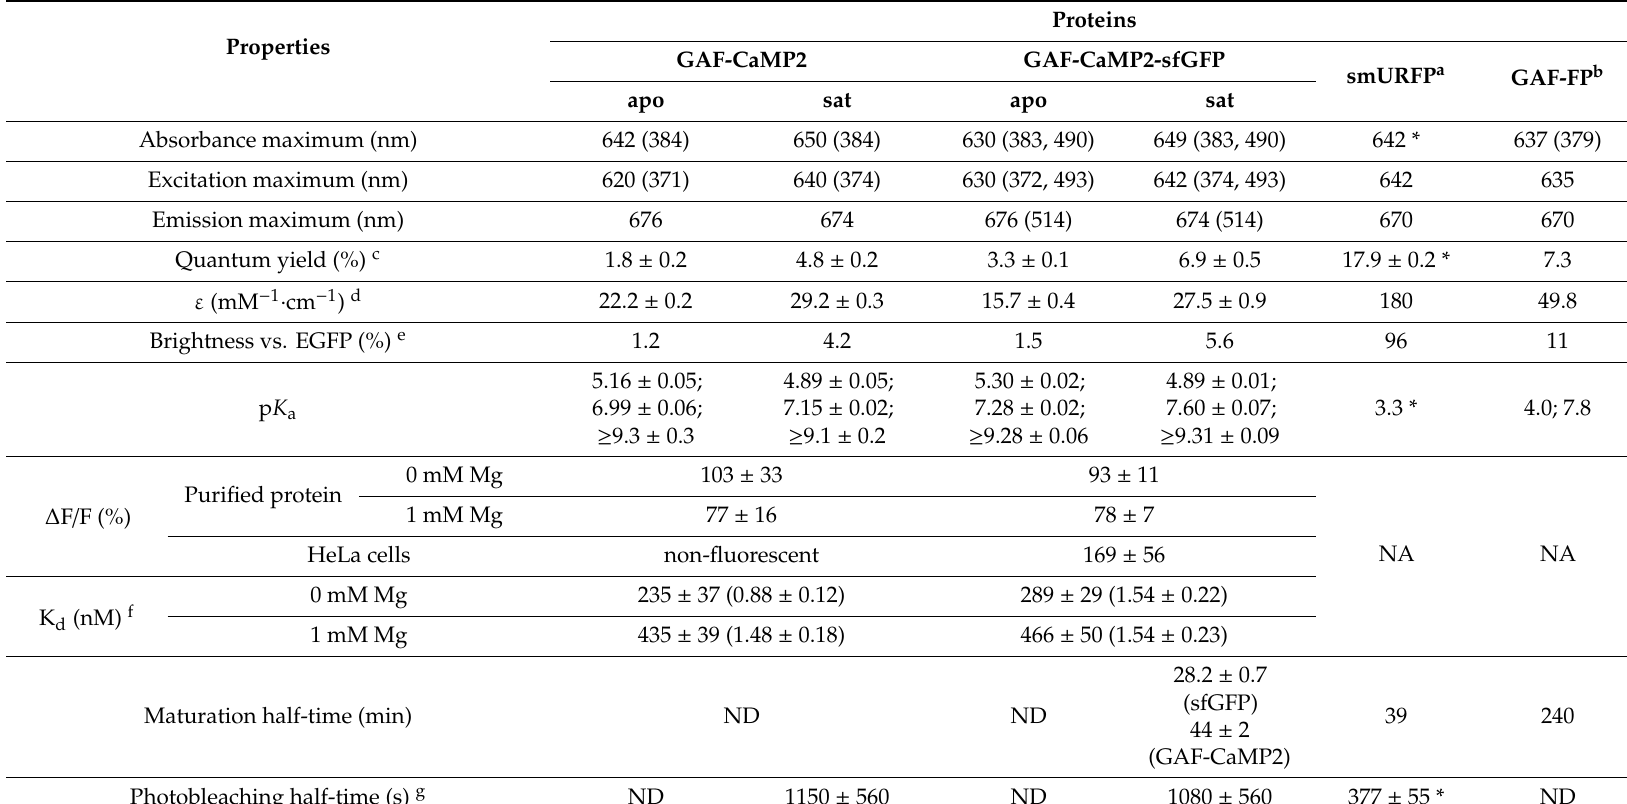
Table 1. In vitro properties of the GAF-CaMP2 calcium indicator compared to permanently fluorescent smURFP and GAF-FP proteins.